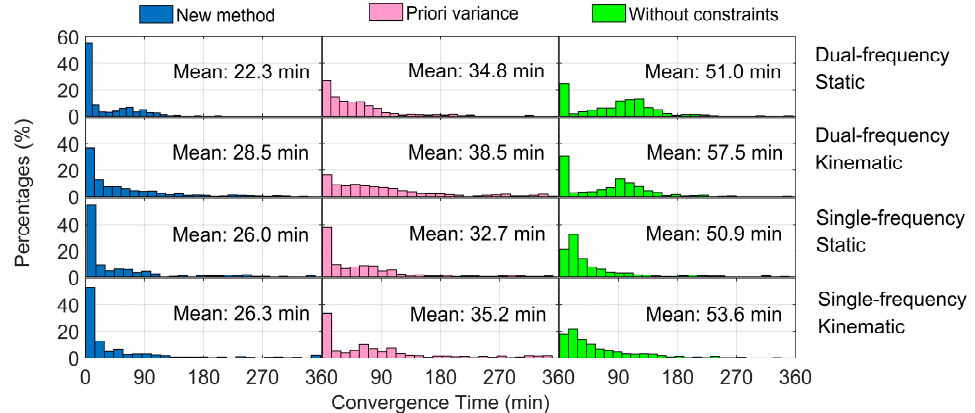
Figure 7. Distribution of convergence time for dual-frequency static, dual-frequency kinematic, single-frequency static, and single-frequency kinematic using datasets at 31 MGEX stations over thirty days.